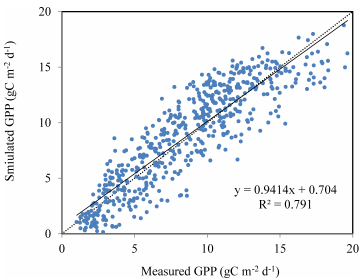
Figure 3. Comparison of the simulated GPP with eddy covariance measurements at the Yucheng site.